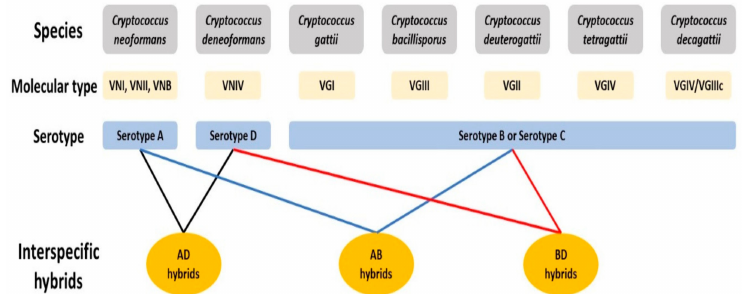
Figure 1. The currently recognized species in the pathogenic Cryptococcus species complex. The seven species of this complex can be distinguished based on genetic and molecular di ff erences, and each is assigned a distinct molecular type based on clade assignment using multilocus sequence typing markers. Historically, cryptococcal strains were broadly categorized into serotypes based on the antigens found at the cell surface. Hybrids arising from mating between species are named based on the serotypes of the parental